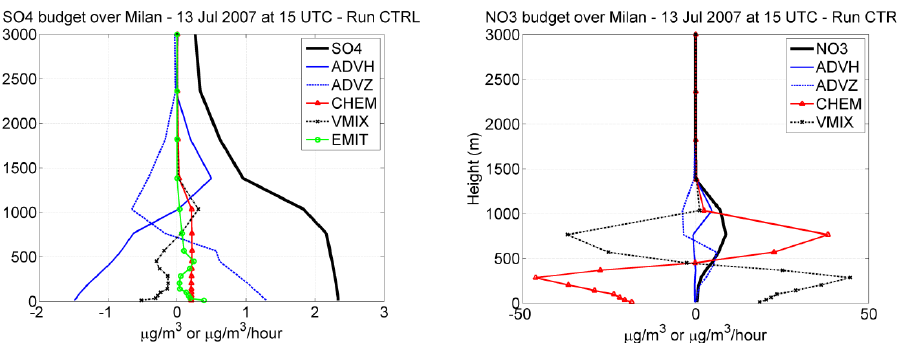
Figure 9. Simulated vertical profile of concentration (µgm − 3 ) and continuity equation terms (µgm − 3 h − 1 ) for particulate sulfate (left) and nitrate (right) at 16:00LST on 13 July 2007 over Milan. Budget terms are horizontal advection (ADVH), vertical advection (ADVZ), chemistry (CHEM), turbulent mixing and dry deposition (VMIX) and emission